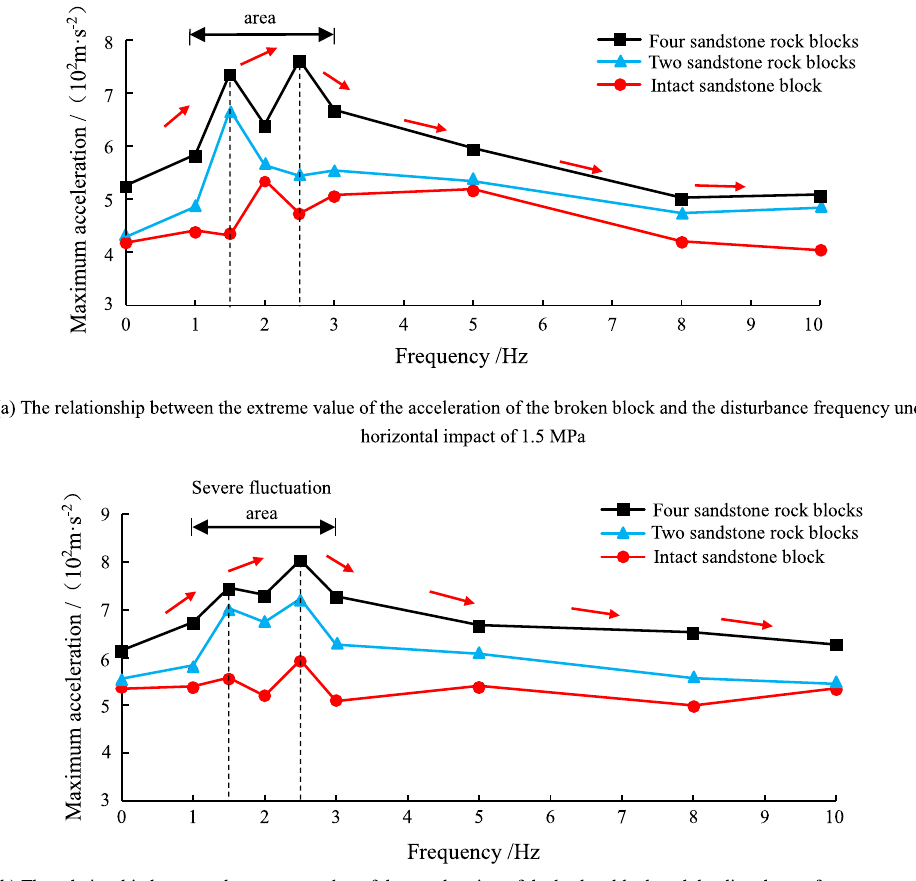
Fig. 8 Curves of the maximum acceleration of blocks broken to varying degrees with changes in the disturbance